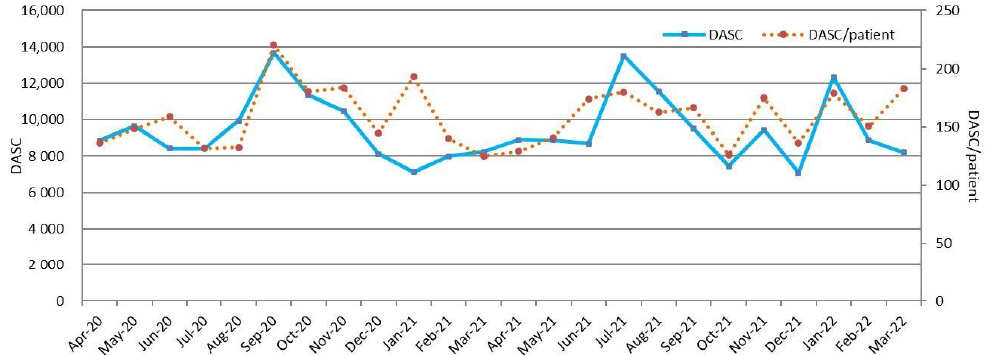
Figure 1. Monthly DASC and DASC/patient trends during this 2-year period. DASC, days of antibiotic spectrum coverage.